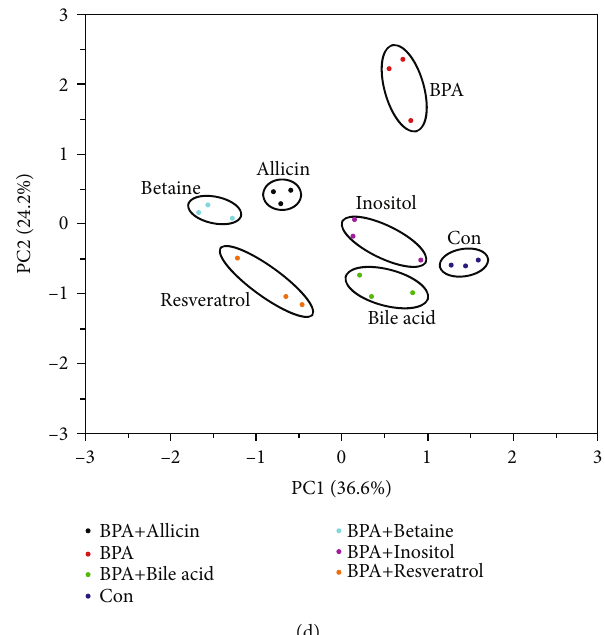
Figure 3: mRNA expression of lipid metabolism-related genes of rare minnow following BPA and experimental additives treatment. (a) TG lipidolysis related genes; (b) TG synthesis related genes; (c) TG transport related genes; (d) the PCA analysis results of lipid metabolism- related genes. All statistical data were expressed as mean ± SD ( n =3). ∗ stands for there is a signi fi cant di ff erence between the treatment groups and Con groups ( P < 0 : 05